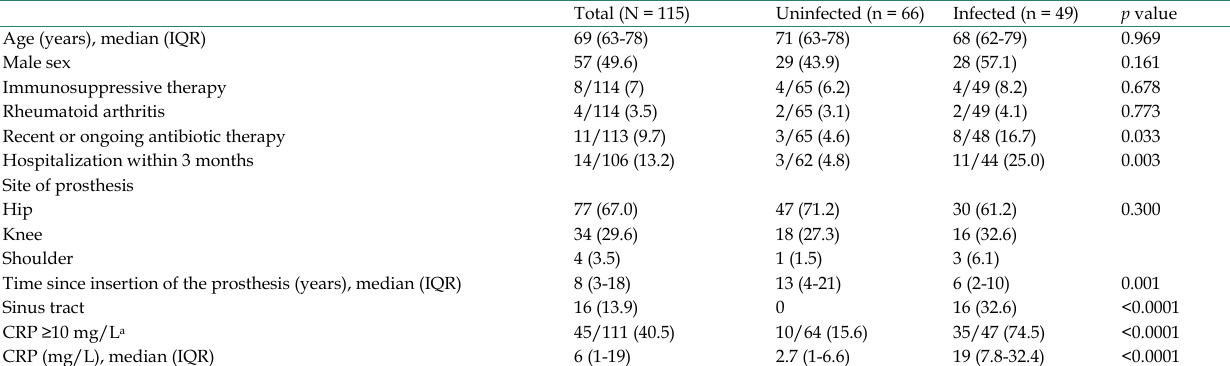
Table 1. Baseline characteristics of the study population